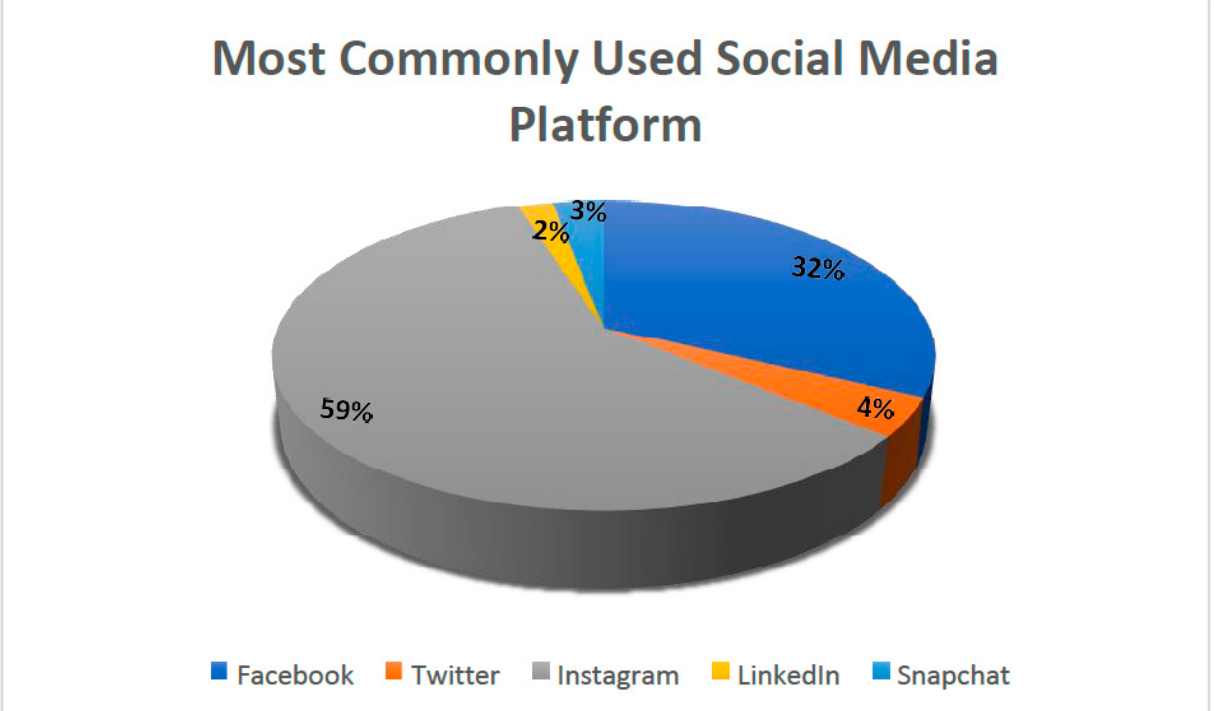
Figure 2. Social media platforms most commonly used by the participants.